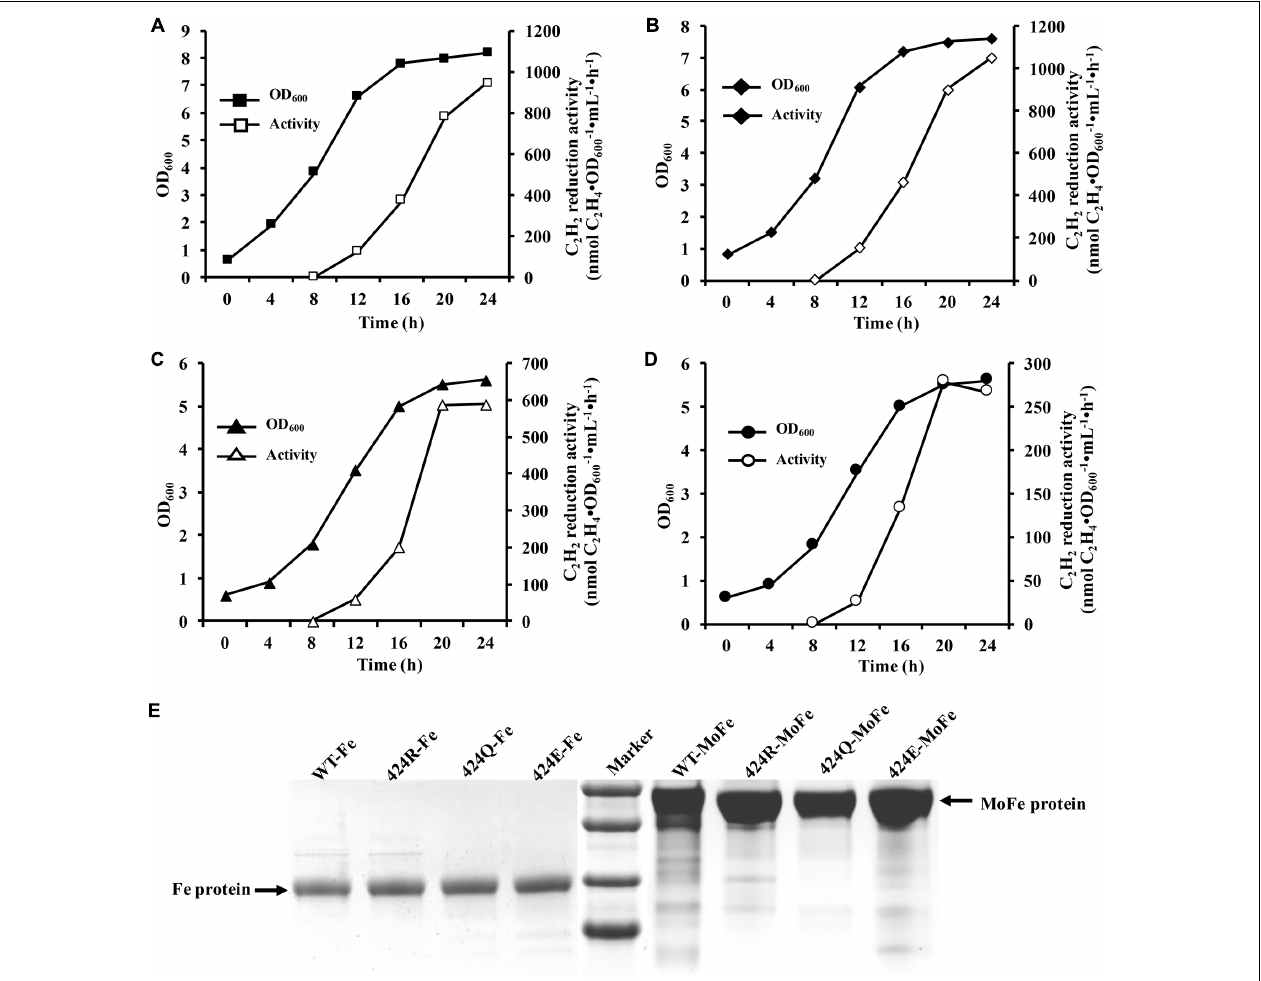
FIGURE 3 | Diazotrophic culture in autofermenter and nitrogenase purification. (A–D) Anaerobic growth of WT, 424R, 424Q, and 424E in 42-L autofermenter (30 ◦ C, 200 rpm, pH 6.8, automatic regulation by 10 M KOH). (E) Tricine-SDS-PAGE analysis of purity of Fe and MoFe proteins.